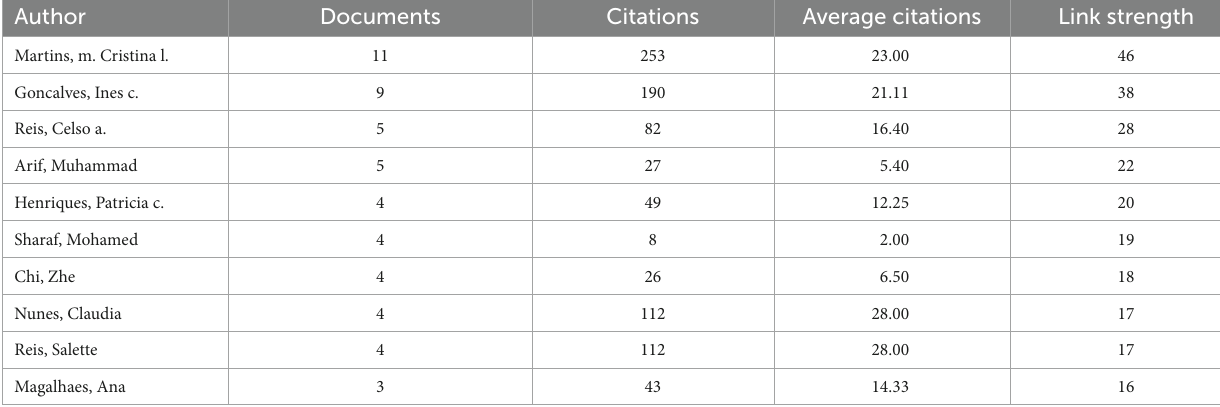
TABLE 3 Analysis of the output and co-authorship of the top 10